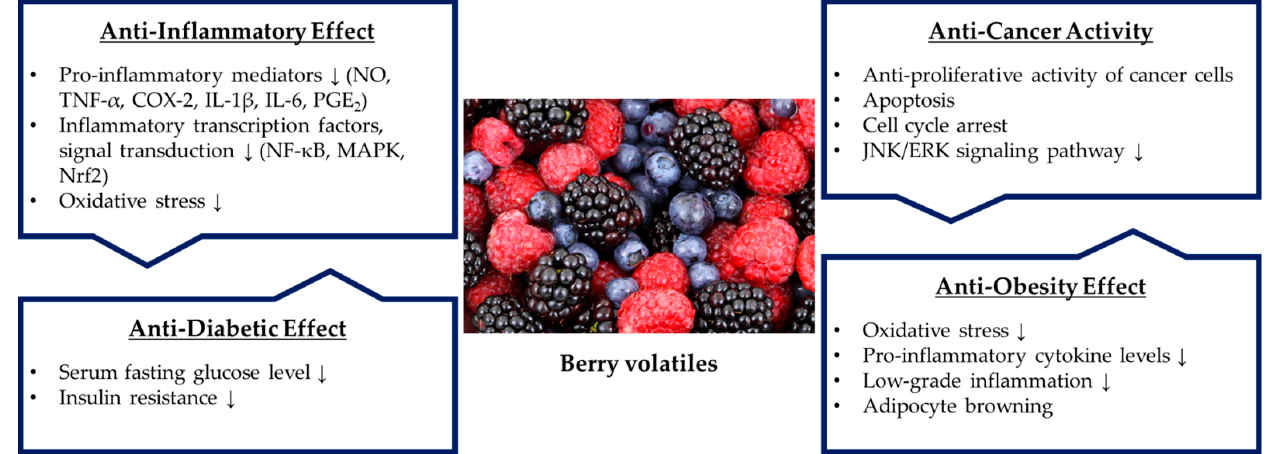
Figure 2. Potential bioactivities of berry volatiles. COX-2 = cyclooxygenase-2; ERK = extracellular signal-regulated kinase; IL-1 β = interleukin-1 β ; IL-6 = interleukin-6; JNK = c-Jun N-terminal kinase; MAPK = mitogen-activated protein kinase; NF- κ B = nuclear factor kappa B; NO = nitric oxide; Nrf2 = nuclear factor erythroid 2-related factor 2; PGE 2 = prostaglandin 2; TNF- α = tumor necrosis factor- α ; ↓ = decrease .